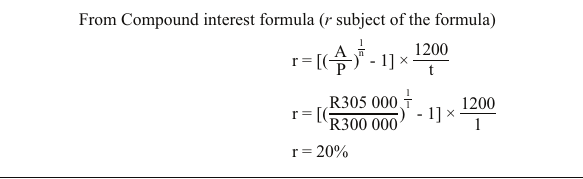
FIGURE 22: Calculating rate of interest.